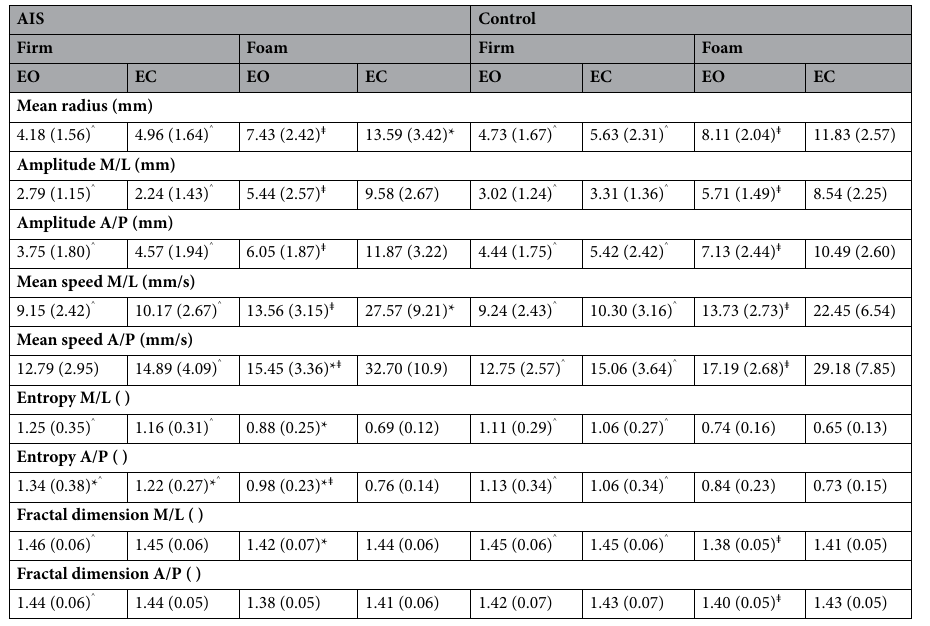
Table 2. Mean values (SD) of the COP parameters for two groups (AIS and CONTROL) standing on Firm or Foam surface with eyes open (EO) or closed (EC) in the sagittal (AP) and frontal (ML) plane. * ˄ǂ Significant (p < 0.05) differences between: *groups, ˄ surfaces, and ǂ visual